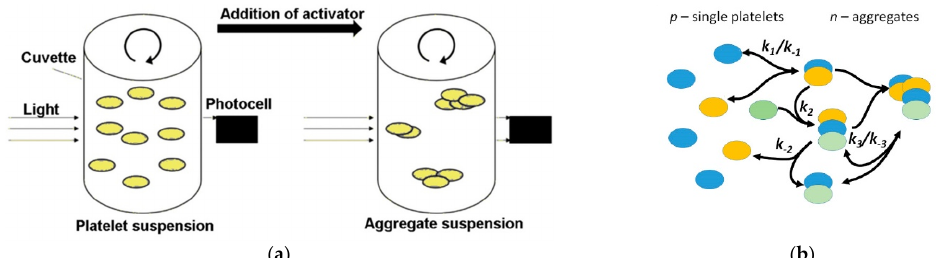
Figure 1. Schemes of experimental ( a ) and theoretical ( b ) processes of platelet aggregation in suspension. ( a ) Conventional light transmission aggregometry. A ray of light after passing through a cuvette with a suspension of platelets enters the photocell. Due to the formation of large local light scattering centers—platelet aggregates—the total light transmission of the suspension increases. The light transmission measured by the aggregometry determines the degree of platelet aggregation. ( b ) Illustration of a mathematical model of platelet aggregation based on the law of mass action between aggregates ( n ) and single platelets ( p ) [2].